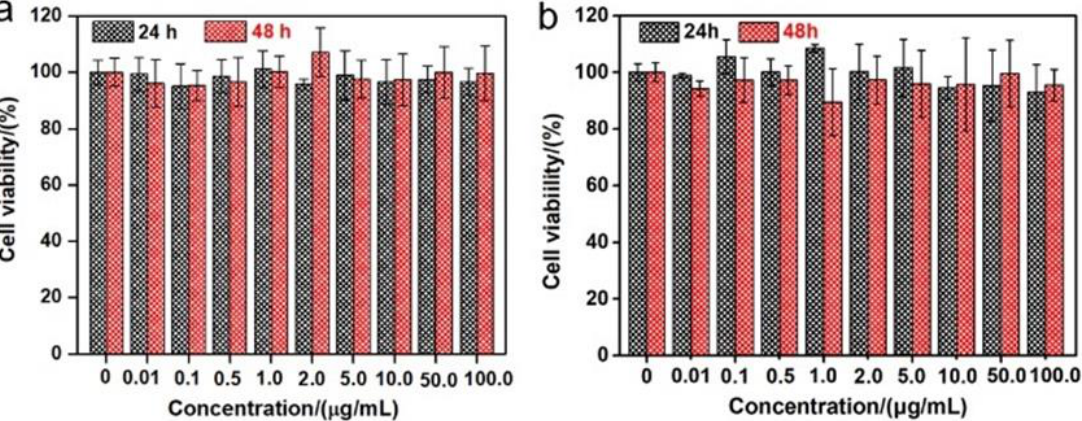
Figure 2. Cytotoxicity experiments of different concentrations of LM@NaAlg by using Hela cells ( a ) and 4T1 cells ( b ).